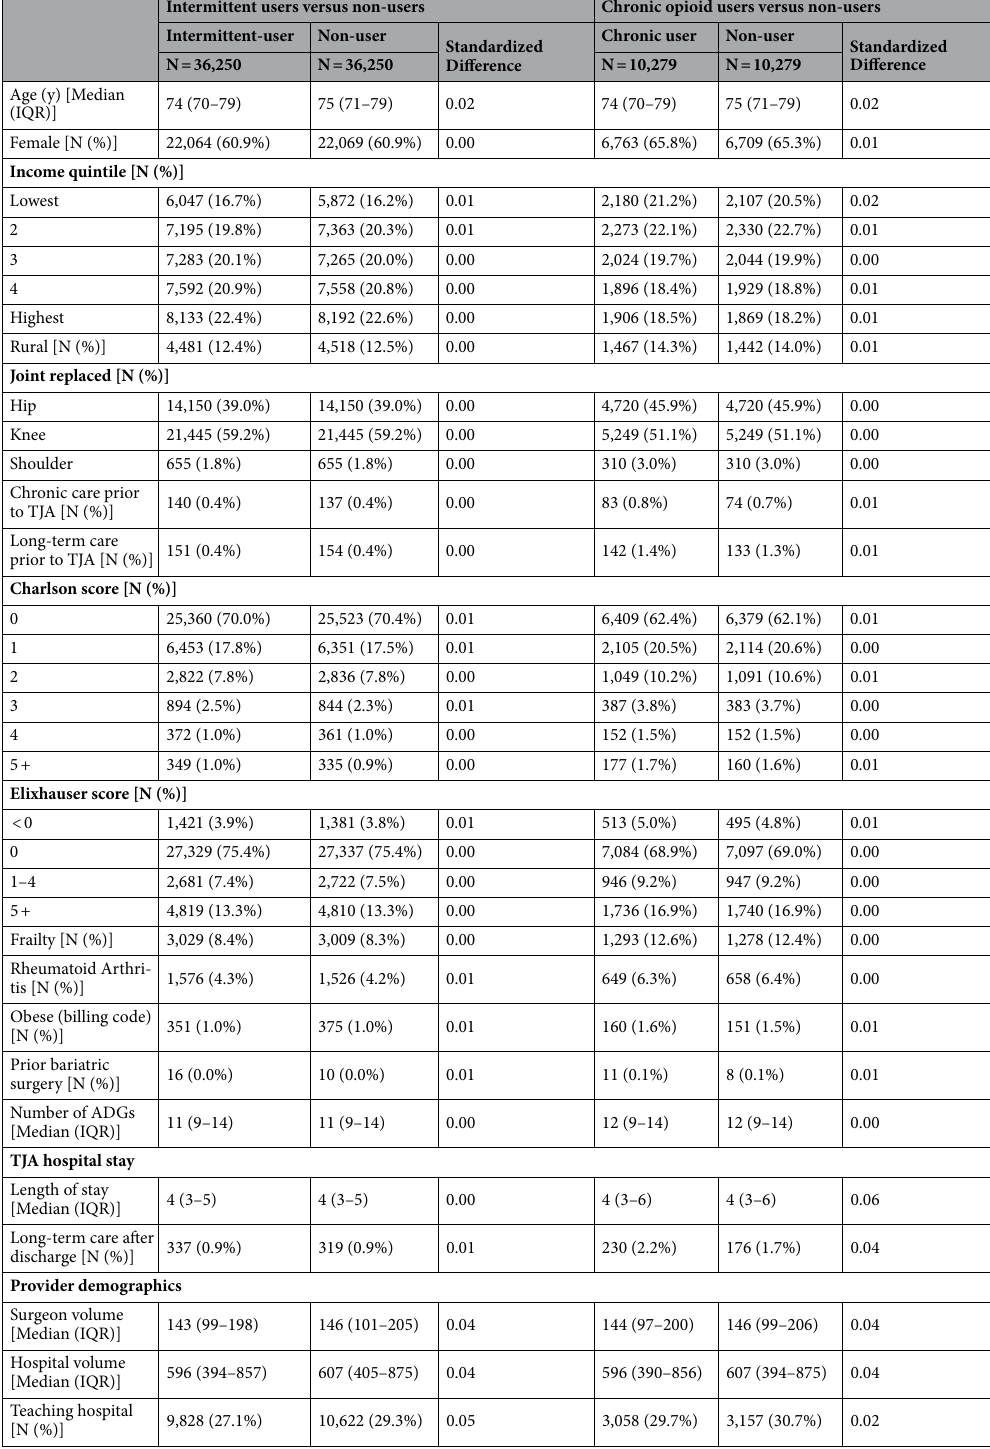
Table 2. Baseline characteristics of matched